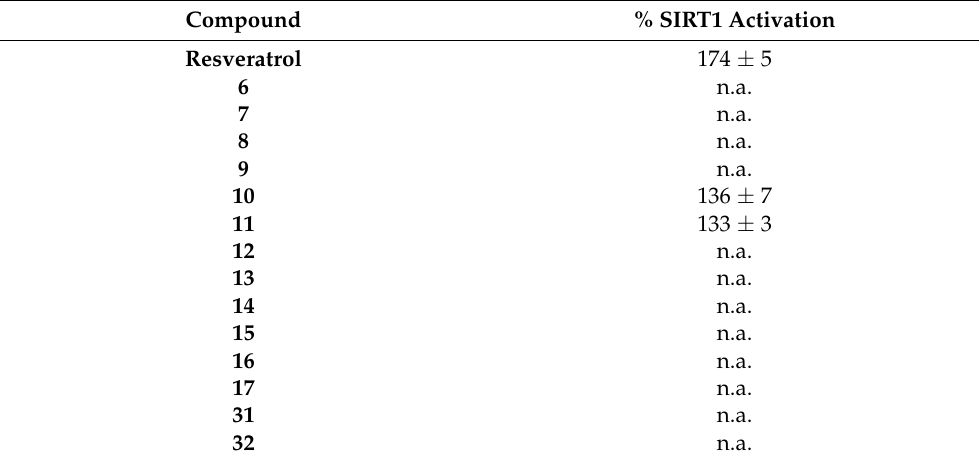
Table 1. The table shows the % of activation of the tested compounds in comparison to resveratrol. n.a. = no